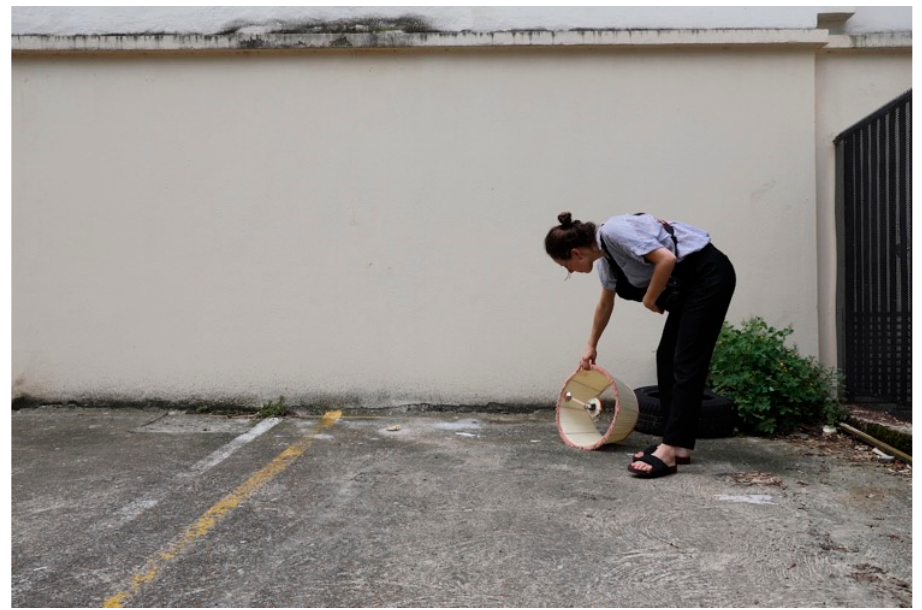
Figure 5. L’Assemblée des Objets Parisiens , GOR, film shooting scene in the Quartier Latin, Paris, 2018. Figure 5. L’Assembl é e des Objets Parisiens , GOR, film shooting scene in the Quartier Latin, Paris,